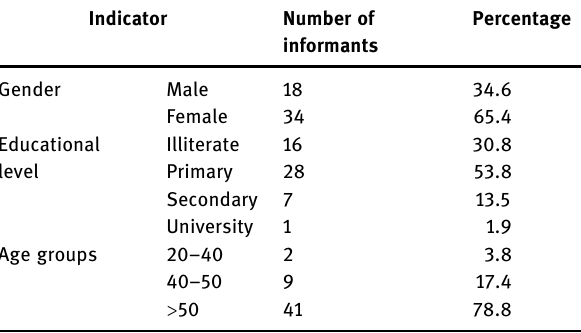
Table 1: Demographic features of